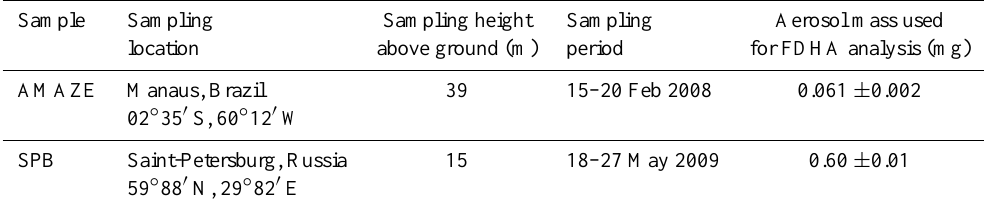
Table 2. Atmospheric aerosol samples. Sample Sampling Sampling height Sampling Aerosol mass used location above ground (m) period for FDHA analysis (mg)